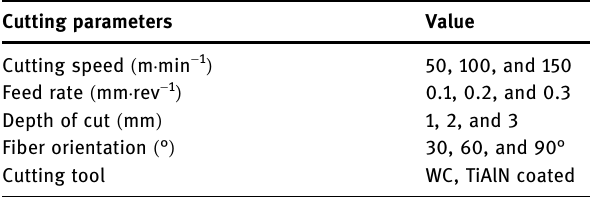
Table 2: Cutting parameters used for